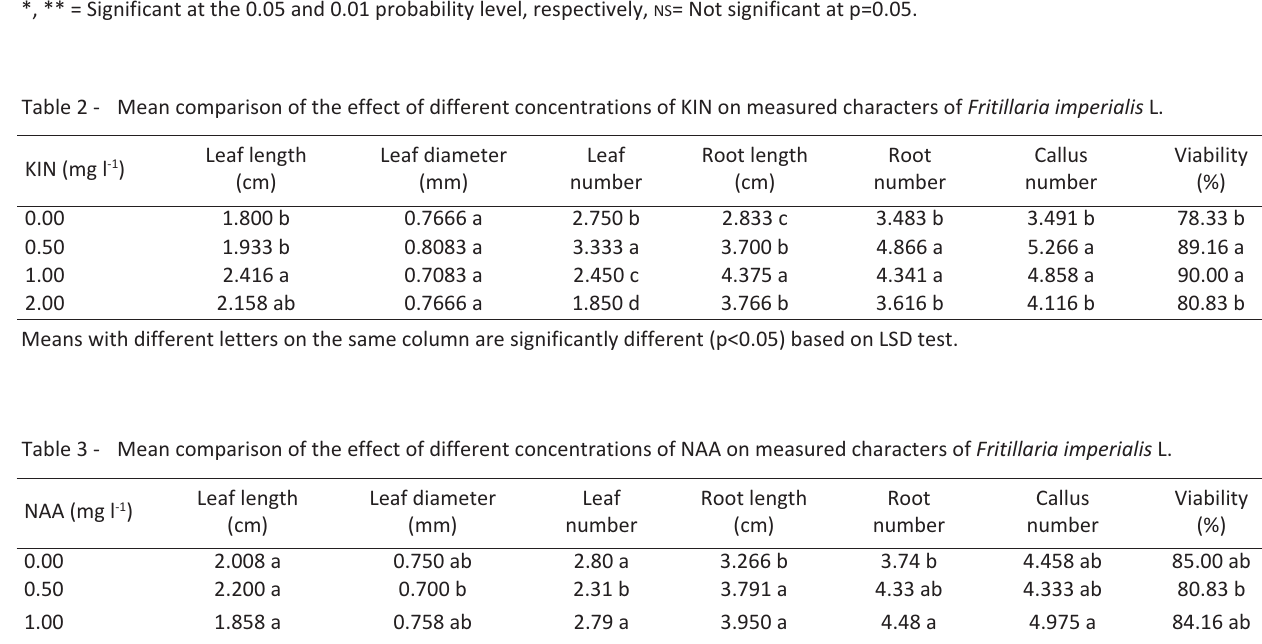
*, ** = Significant at the 0.05 and 0.01 probability level, respectively, NS = Not significant